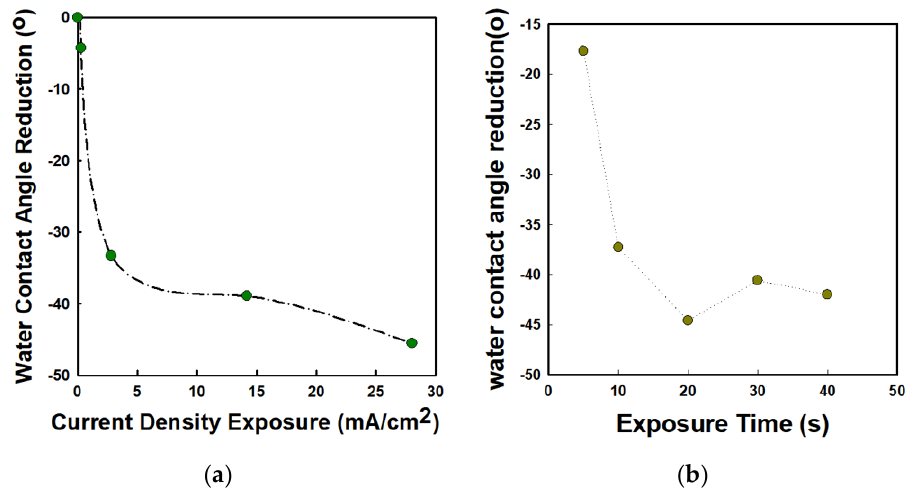
Figure 7. Water contact angle measurement with respect to ( a ) current density and ( b ) exposure time. The exposure time and current were fixed at 20 s and 0.28 mA/cm 2 , respectively.